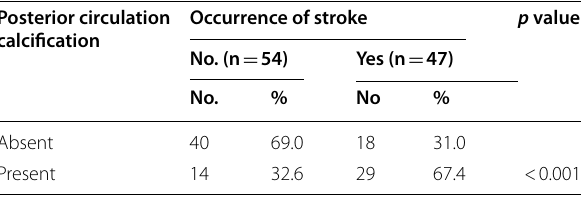
Table 3 Association of posterior circulation calcification